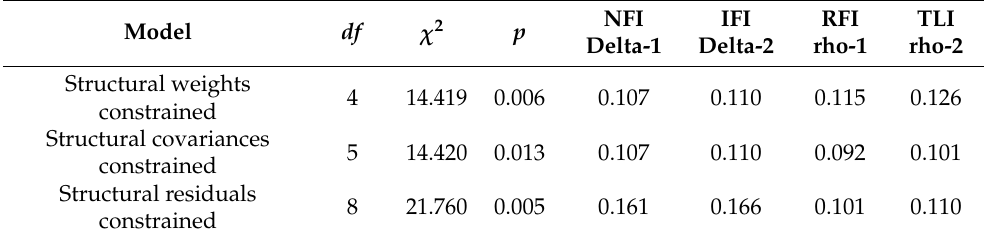
Table 3. Comparison of nested model.